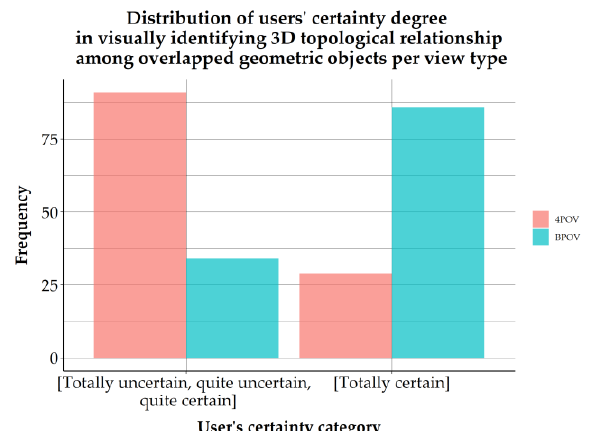
Figure 7: Distribution of users’ certainty degree in visually identifying visual 3D topological relationship among